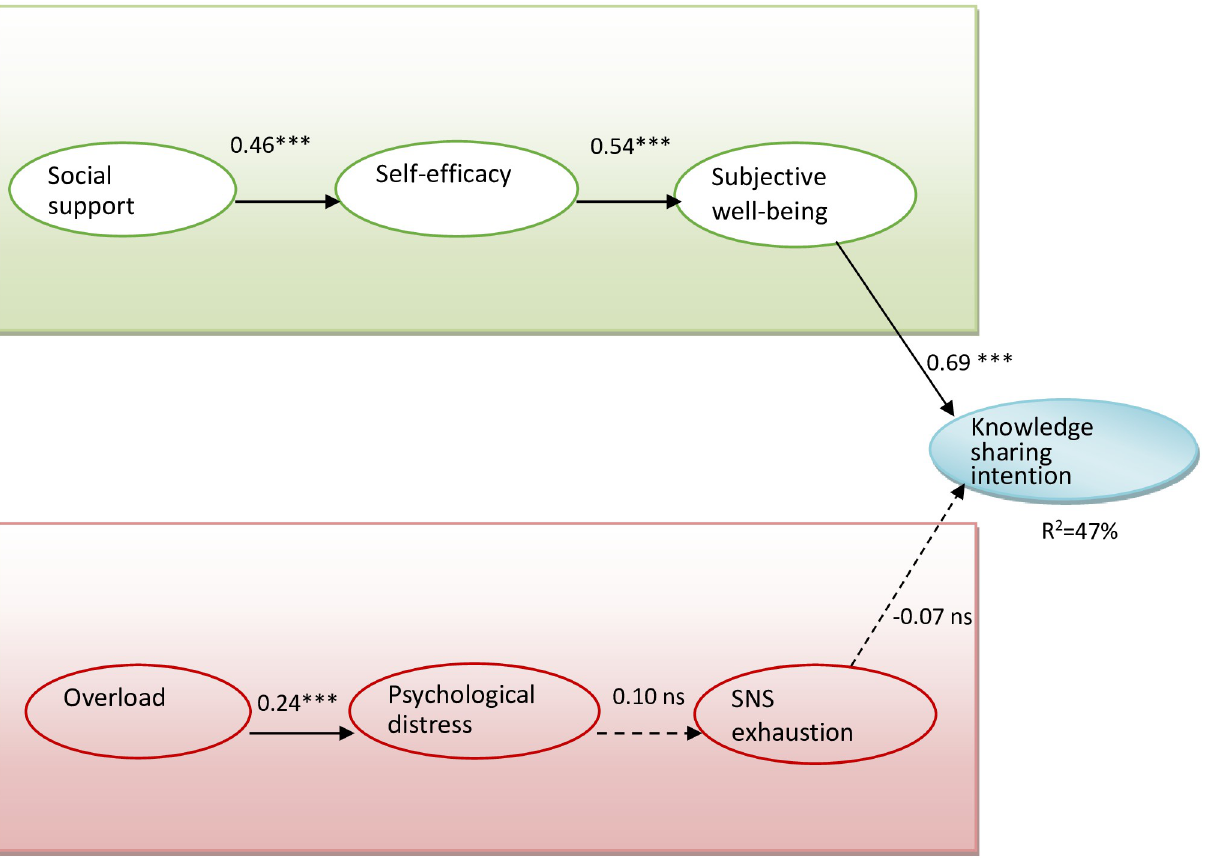
Fig 2. Path analysis of this study. ��� p < 0.001 ns.